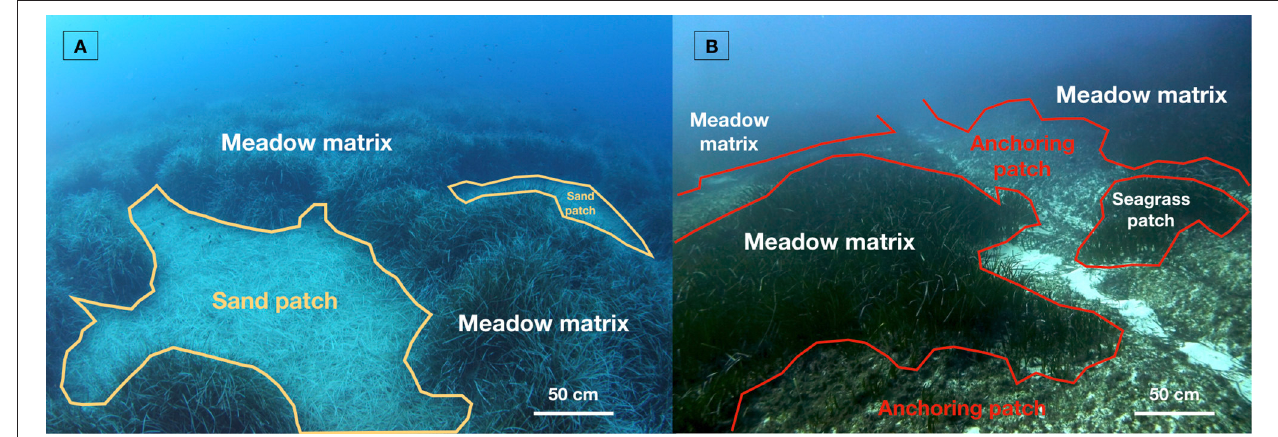
FIGURE 1 | Two contrasted P. oceanica seascapes in Calvi Bay at 20 m depth (Corsica, France): (A) a natural seascape made of sand patches generated by water movements; (B) a seascape impacted by intensive anchoring leading to dead matte patches. Photos: A.